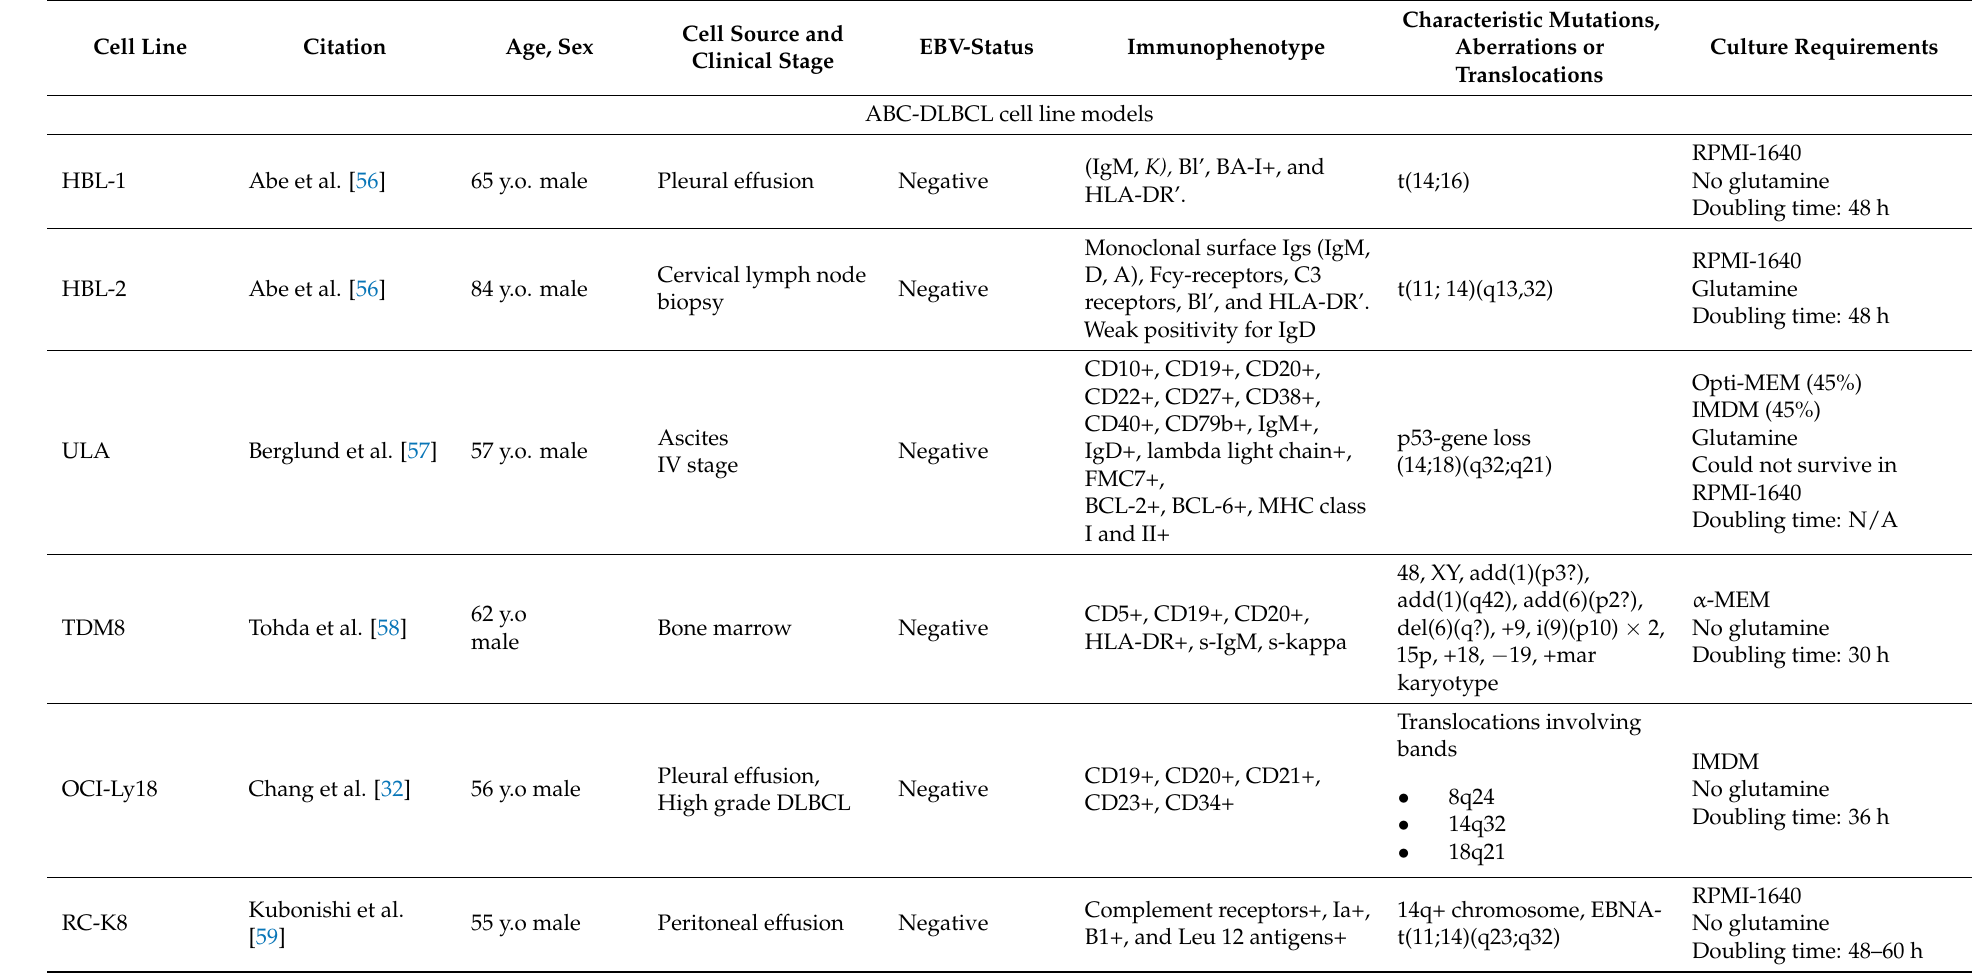
Table 1. Overview of the cell lines used to study